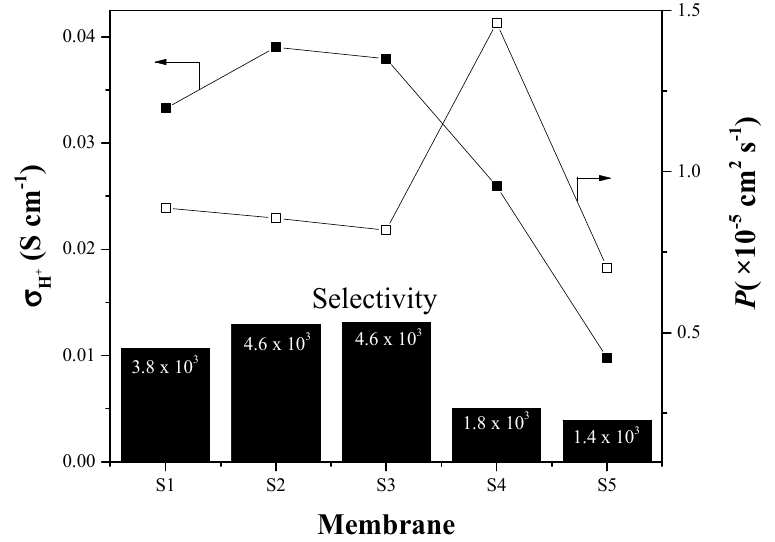
Figure 6. Proton conductivity, methanol permeability at 8 h and proton selectivity under wet conditions at 30 °C.